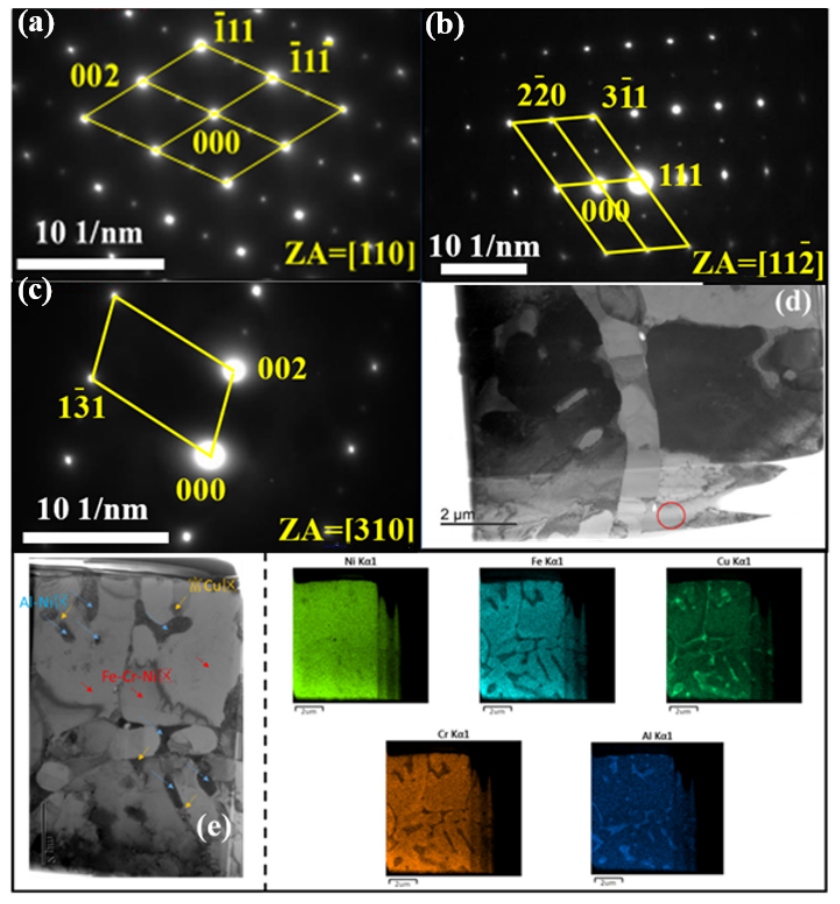
Figure 8. ( a–d ) TEM morphology and selected electron diffraction (SAED) spectrum of 4# powder., ( e ) EDS analysis of 4# high entropy powder in TEM tests.